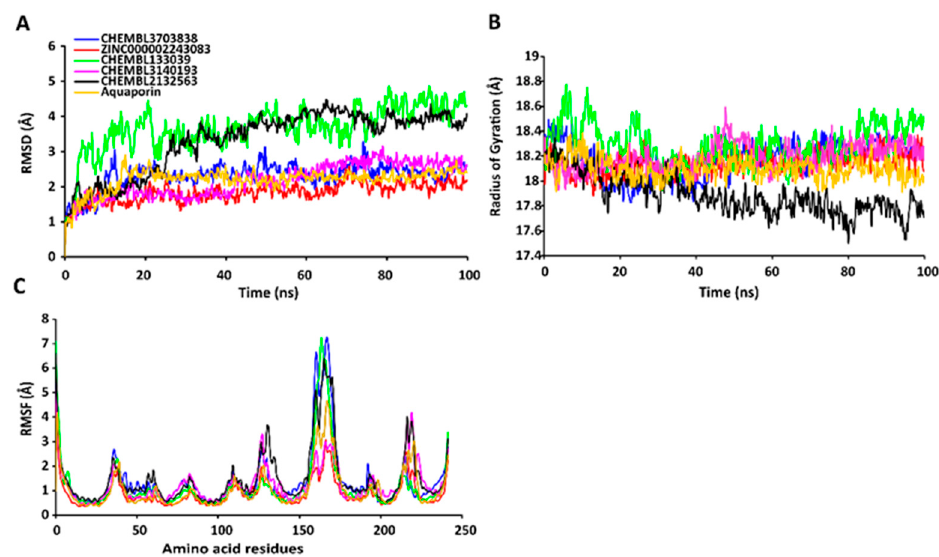
Figure 3. Stabilities of the protein-ligand complexes during 100 ns MD simulations. ( A ) RMSD values of the protein-ligand complexes fitted to the C α backbone of AQP. The x -axis depicts the duration of simulation, while the y -axis represents the deviation. ( B ) Analysis of the Rg values of the protein-ligand complexes. The x -axis depicts the duration of simulation, while the y-axis represents the deviations in Rg. ( C ) RMSF values of the C α backbone of AQP. The x -axis depicts the total number of residues, while the y-axis represents the RMSF in Å. The different ligands complexed with AQP are represented by lines of different colors.